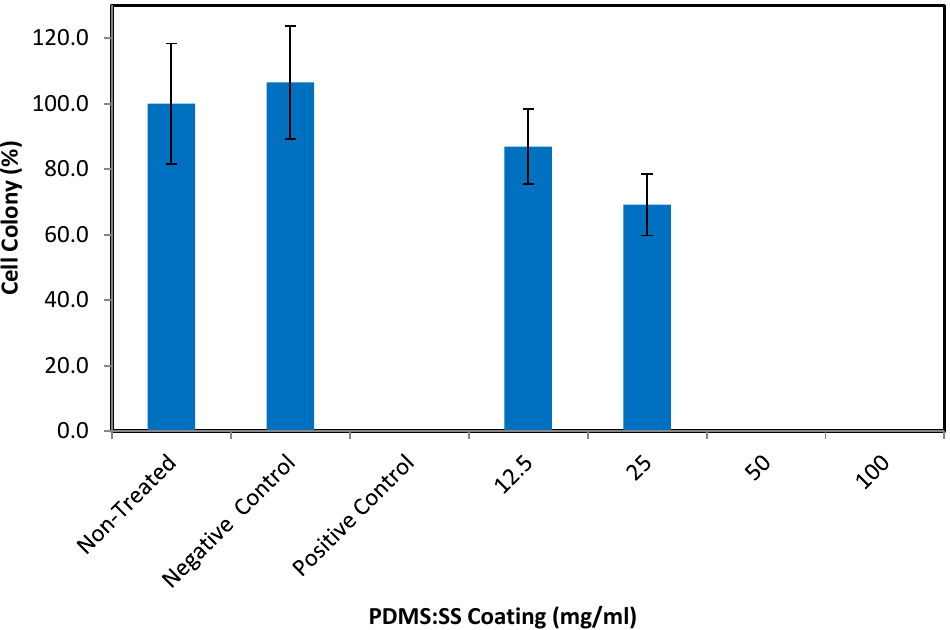
Figure 4. The colony percentage of viable V79 cell. The experiments were conducted in triplicate independently (n = 3), and the data are expressed as the means ± standard deviation (SD) with p < 0.05.